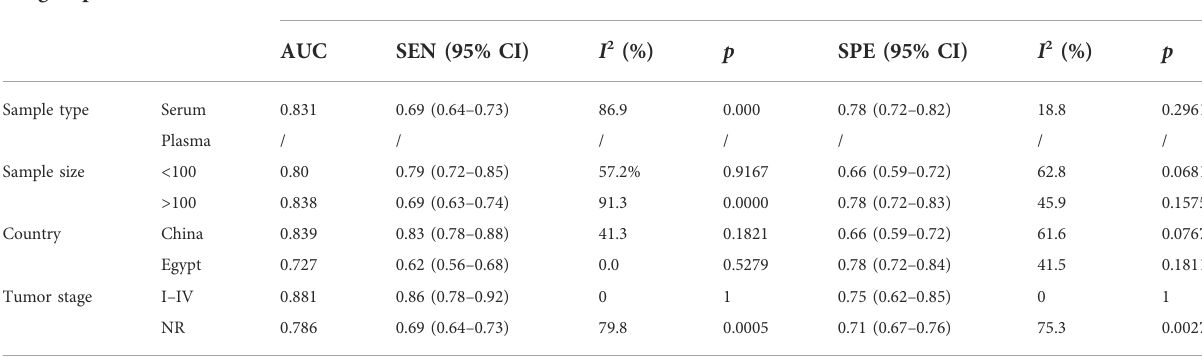
TABLE 2 Subgroup analysis of the diagnostic value of the miR-17-92 cluster in HCC.